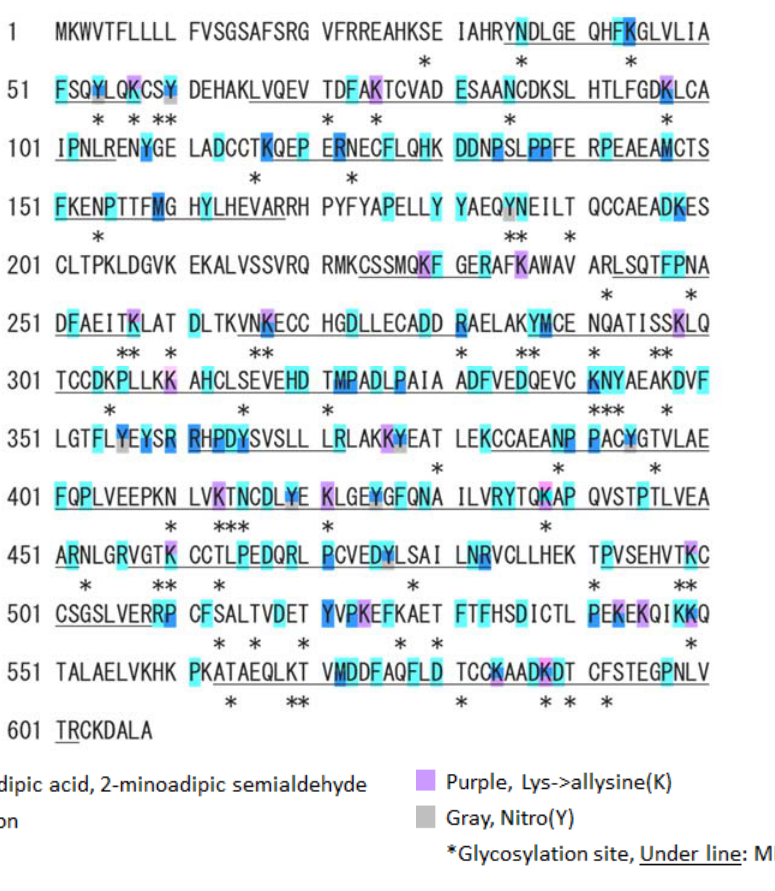
Figure 2. Oxidative modification of SA obtained from single TBI exposure. Identified MSA sequences and their oxidative modification by LS-MS/MS. The modification sites are marked as follows: pink, aminoadipic acid; light blue, oxidation; blue, dioxidation; yellow, γ -glutamyl semialdehyde; purple, allysine; and grey, nitrotyrosine. Glycated or glycosylated amino acids are indicated with asterisks. The peptides targeted by an MRM ‐ HR are underlined.